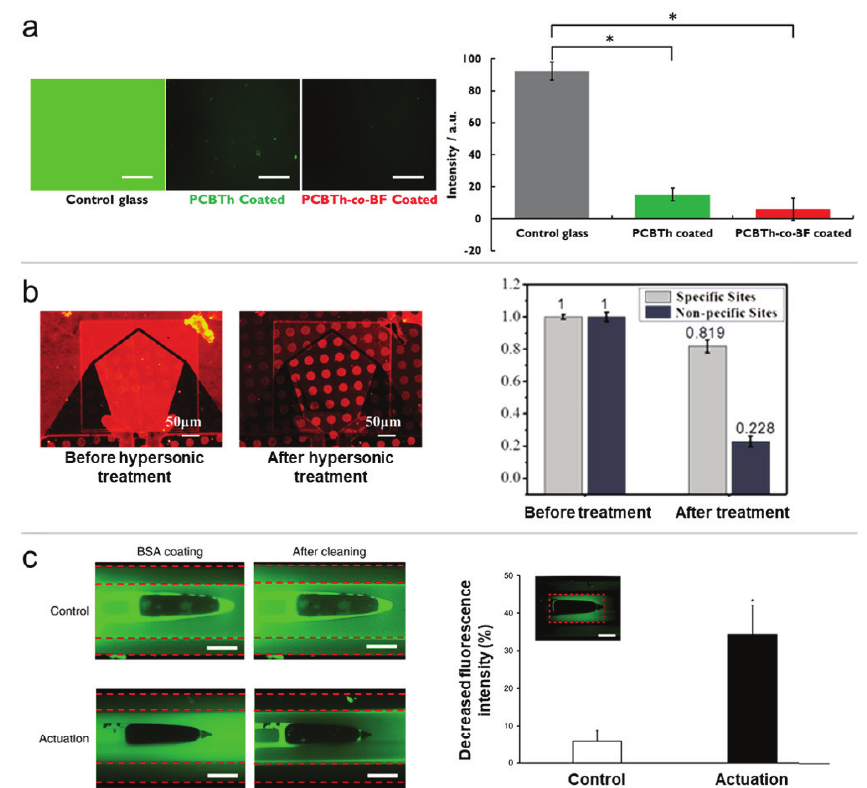
Figure 2. ( a ) Zwitterionic linear and porous polymers prevented protein binding to the surfaces. Scale bar = 200 µm. Adopted from [110]. ( b ) Using a hypersonic resonator, non-specific bound proteins were selectively removed. Adopted from [90]. ( c ) Proteins adsorbed to the actuators and surrounding tubing surfaces was removed during magnetic actuation. Scale bar = 200 µm. Adopted from [91].